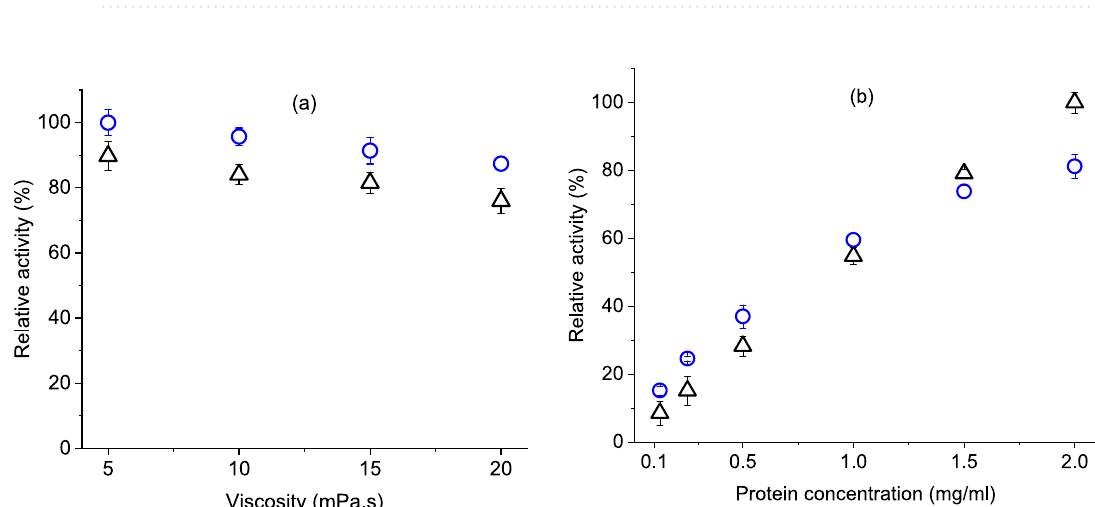
Figure 3. Activity of tyrosinase ink containing carboxymethyl cellulose (∆) and poly-vinyl alcohol (O) as viscosity modifiers at various ( a ) ink viscosities (same protein concentration) and ( b ) protein concentrations (same viscosity). Results are expressed as percentages against the highest activity found for each